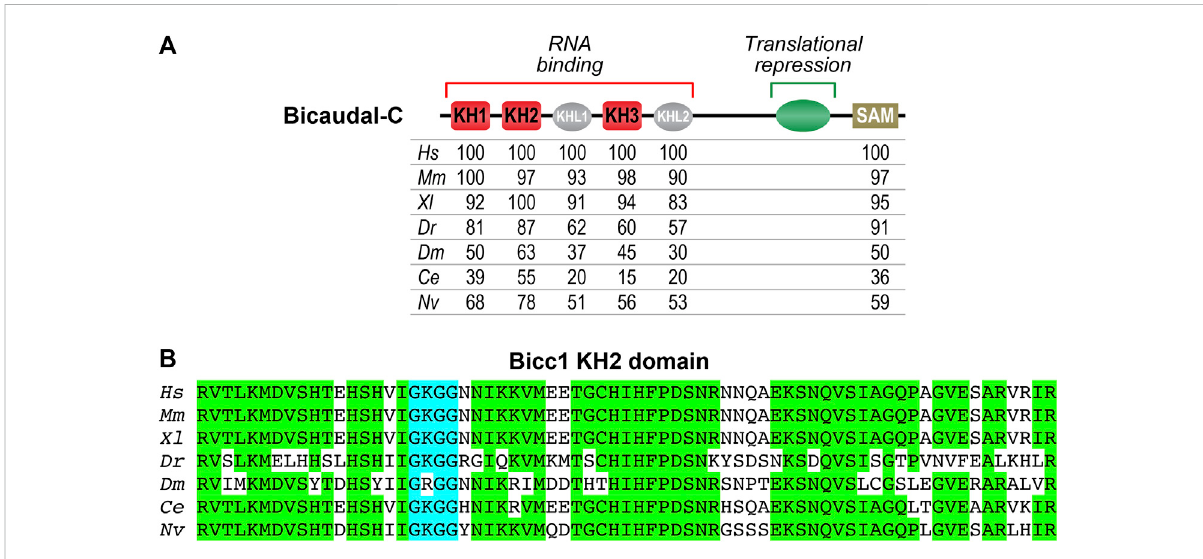
FIGURE 1 Evolutionary conservation of Bicaudal-C proteins (A) Diagram of the Bicaudal-C protein highlighting key features. The N-terminal region contains three KH domains (KH1, KH2 and KH3) involved in RNA recognition and binding. The C-terminal region contains a SAM domain that mediatesprotein-proteininteractionsandpromotestheformationofpolymers.Thecentralregionoftheprotein(aa505-806of Xl Bicc1)wasde fi ned through the use of the MS2 tethered function assays as being suf fi cient for translational repression (Zhang et al., 2013). Below the diagram are amino acid identities comparing Bicc1 proteins from different species ( Hs – Homo sapiens , Mm – Mus musculus , Xl – Xenopus laevis , Dr – Danio rerio , Dm – Drosophila melanogaster , Ce – Caenorhabditis elegans, Nv – Nematostella vectensis ). The numbers indicate the percent amino acid identity compared to Hs Bicc1. The different domains are those identi fi ed via the NCBI database. (B) Amino acid sequence comparison of the highly conservedKH2domainsfromdifferentspecies.Thisdomainisakeystructuralfeatureforrecognitionofspeci fi cmRNAsbyBicc1proteinsandoneof the most conserved features of these proteins. Amino acids that are identical are highlighted in green. The KH2 domain ’ s GXXG motif (GGKG) is highlighted in